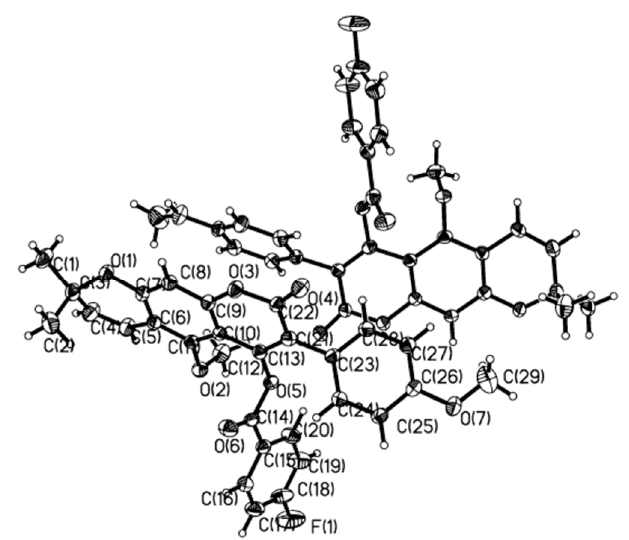
Figure 3. Crystal structure of compound 2f .